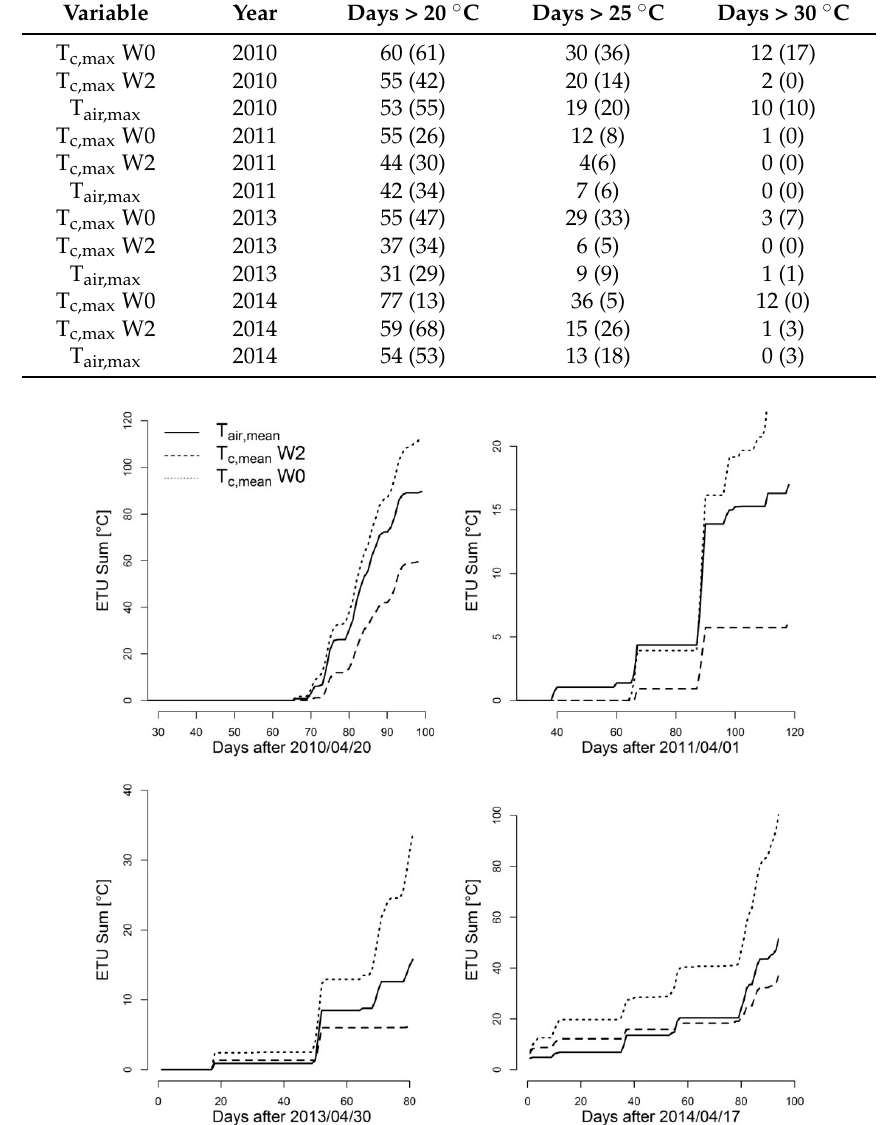
Table 6. Number of days exceeding 20, 25 and 30 °C for modeled maximum daily crop temperature of the drought treatment plot (T c,max W0) and the irrigated plot (T c,max W2) and for the measured maximum daily air temperature (T air,max ) in 2010, 2011, 2013 and 2014 (Hohenschulen research site). In parentheses, values calculated for available measured canopy temperatures are given ( cf . Table 1).